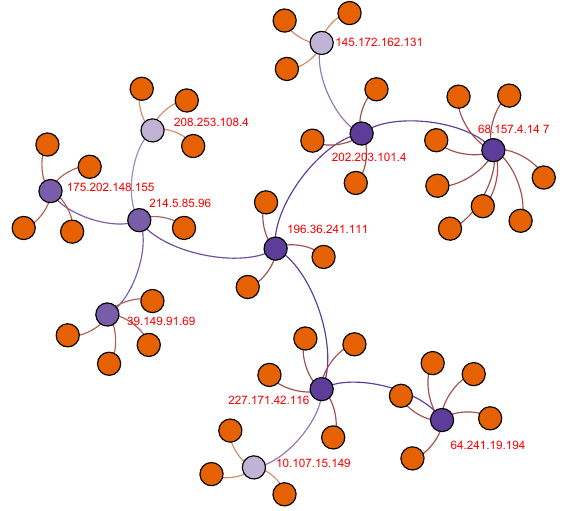
Figure 9. Complete cascading motif captured from the UDP worm